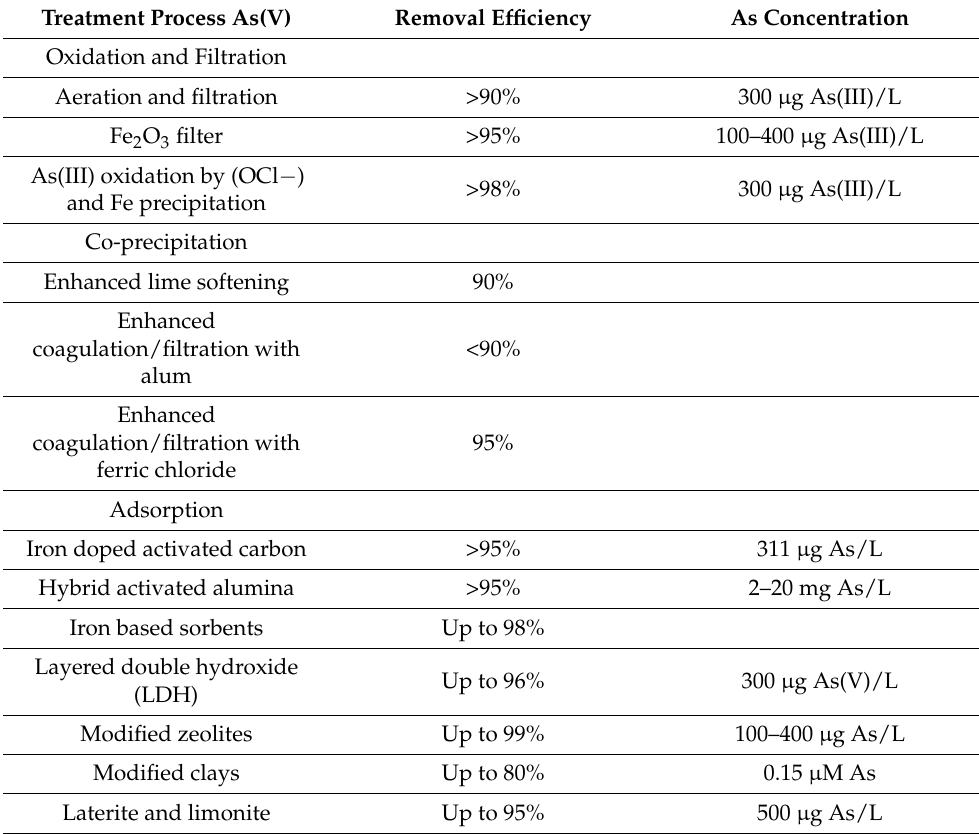
Table 3. Treatment efficiencies reported for some arsenic removal